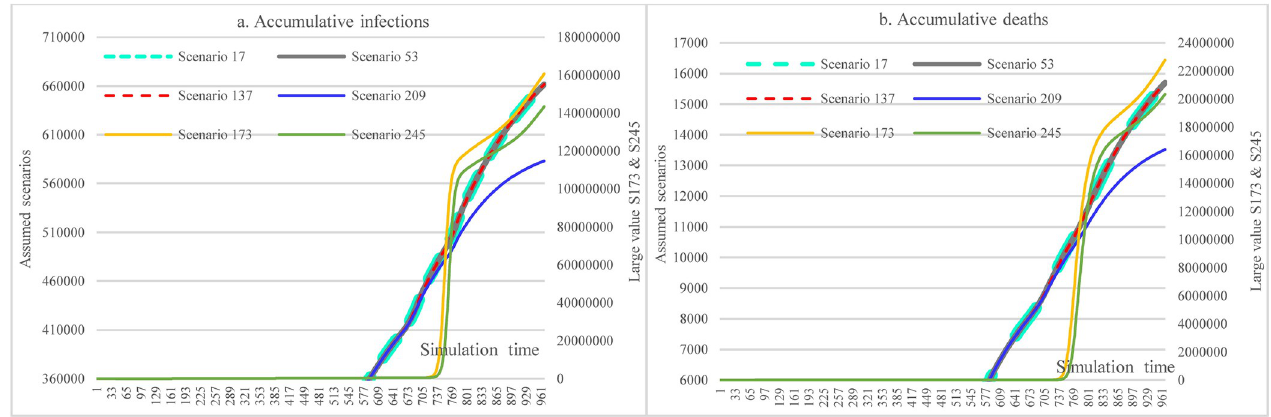
Fig 24. Impacts of hospital capacity in scenario